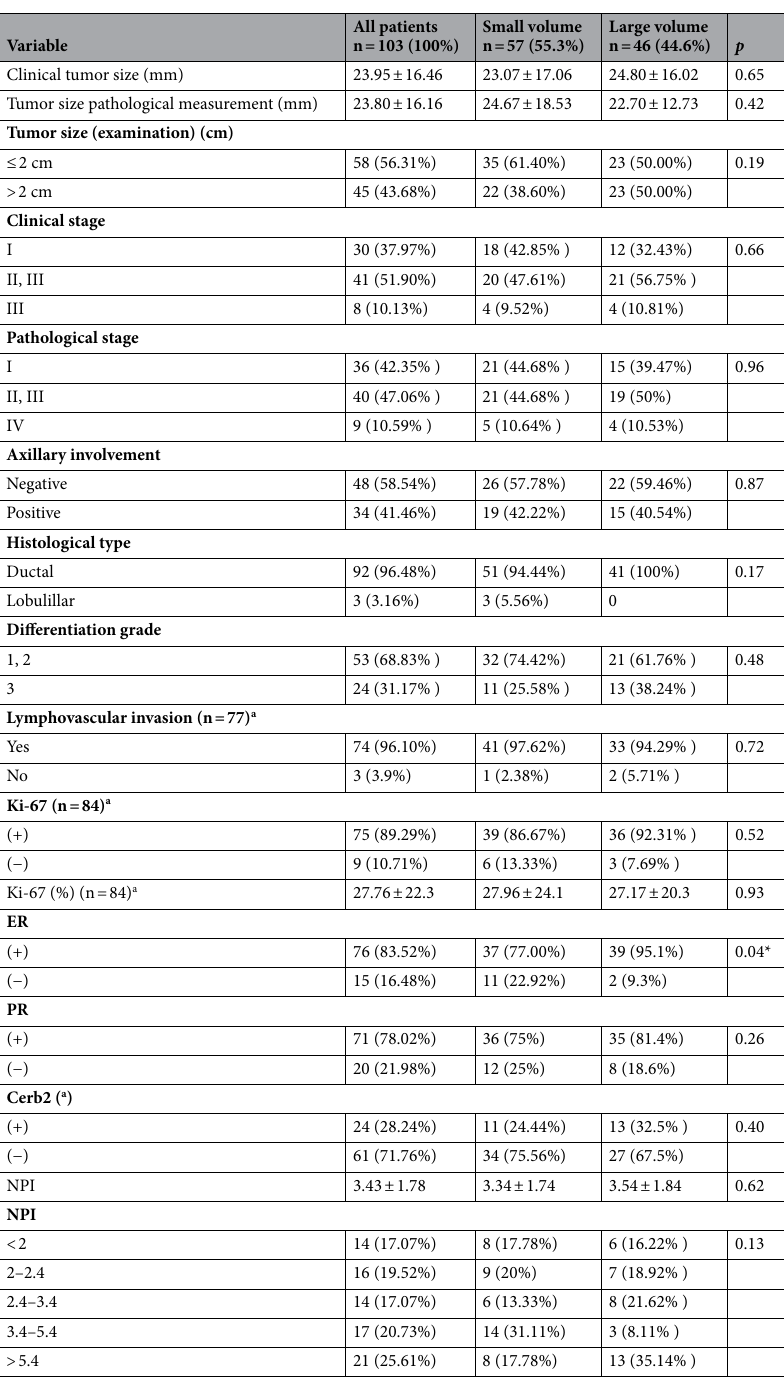
Table 4. Prognostic characteristics of tumor in breast cancer patients according to their breast volume (small vs. large). Data expressed as means ± standard deviation and absolute numbers and their frequencies. NPI Nottingham prognostic index. * p value < 0.05 (t-Student or Chi-squared). a Analysis performed on the cases provided by the pathology